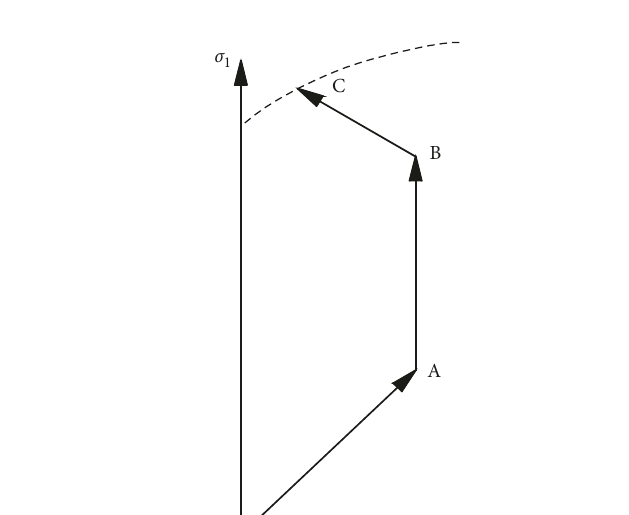
Figure 1: Processing of rock